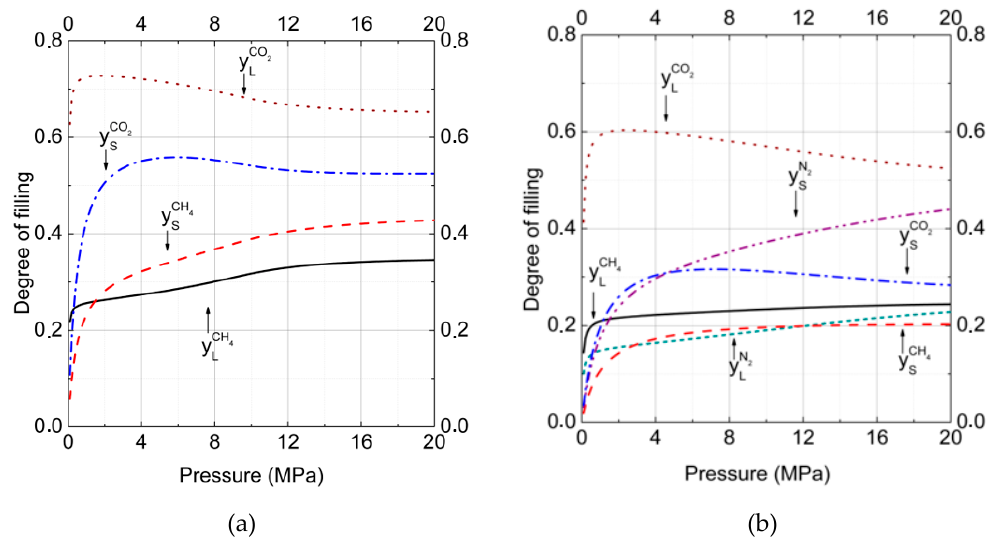
Figure 1. Degree of cage filling for large and small cavities in hydrate at equilibrium conditions at T = 277 K. Gas phase mole fractions were ( a ) a binary mixture containing carbon dioxide (50%) and methane (50%) and ( b ) a ternary mixture containing carbon dioxide (15%), methane (15%), and nitrogen (70%) ( y CH 4 = solid; y CH 4 = dashed; y CO 2 = dotted; y CO 2 = dash-dotted; y N 2 = dash-dot-dotted; and y N 2 = short dashed lines). The total number of calculated points was equal to 200 with a pressure step of 0.1 MPa for each curve.